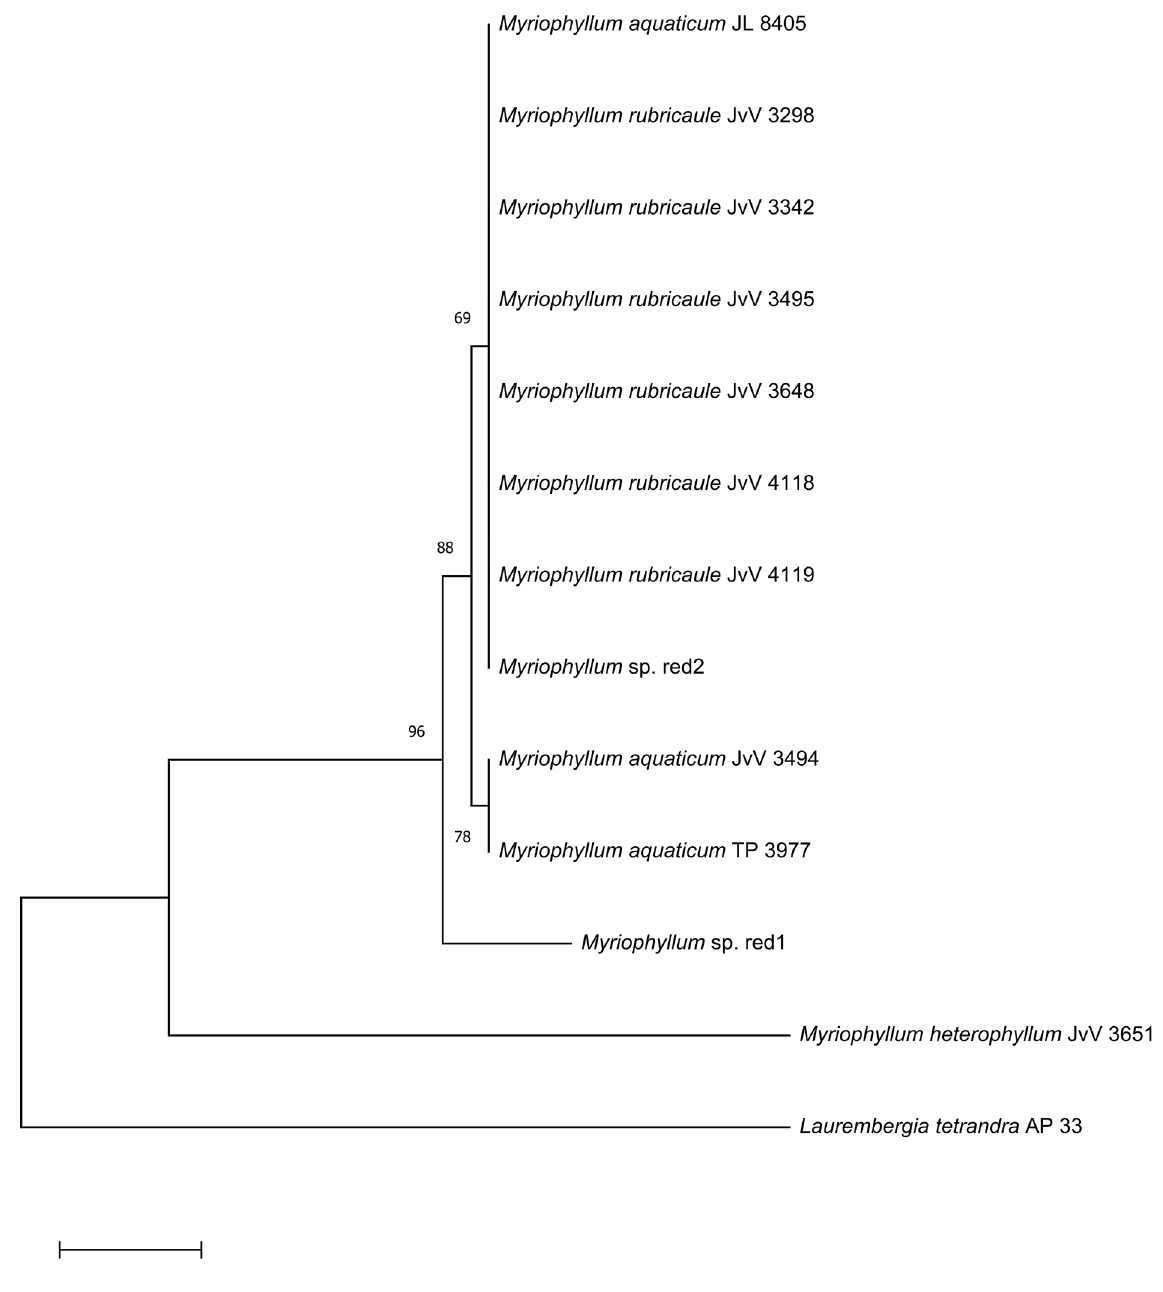
Fig. 3. Maximum likelihood tree based on concatenated trnK3-matK sequences. This tree was inferred by using the Maximum Likelihood method and Tamura 3 parameter model (Tamura 1992). The tree with the highest log likelihood (-2853.86) is shown. Bootstrap values after 1000 replicates are expressed as percentages. The tree is drawn to scale, with branch lengths measured in the number of substitutions per site. Laurembergia tetrandra AP 33 was used as an